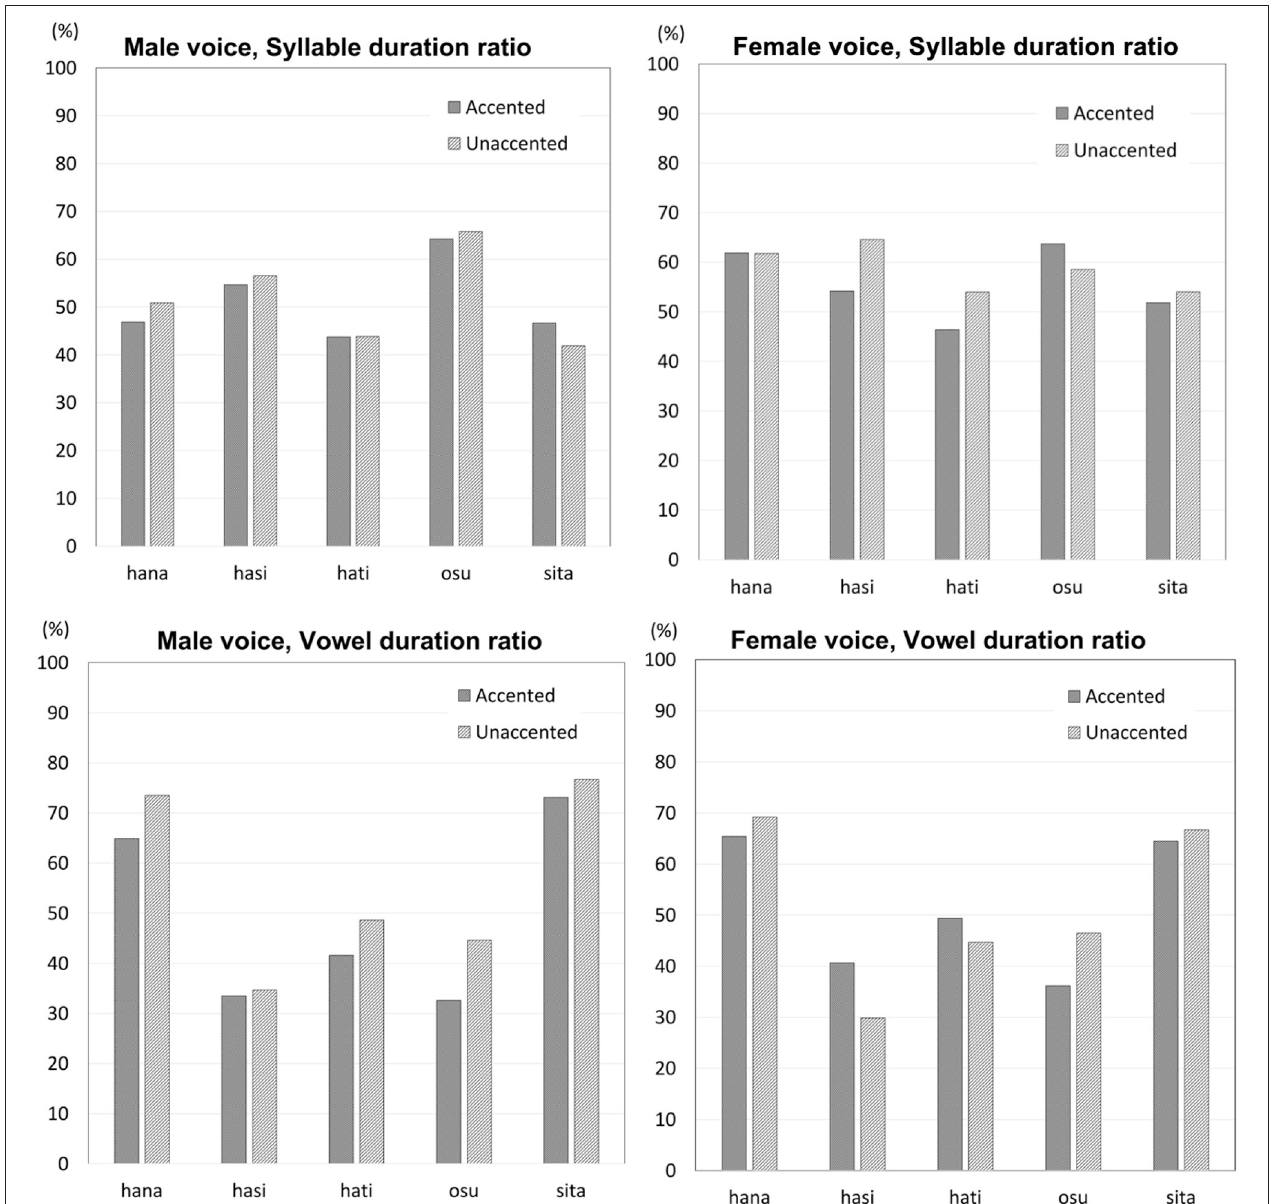
FIGURE 9 | Syllable duration ratios (upper panels) and vowel duration ratios (lower panels) for the male voice stimuli and the female voice